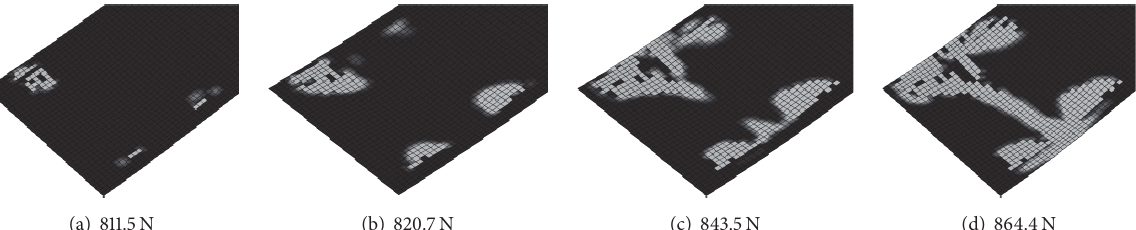
Figure 6: Matrix damage evolution of the skin.